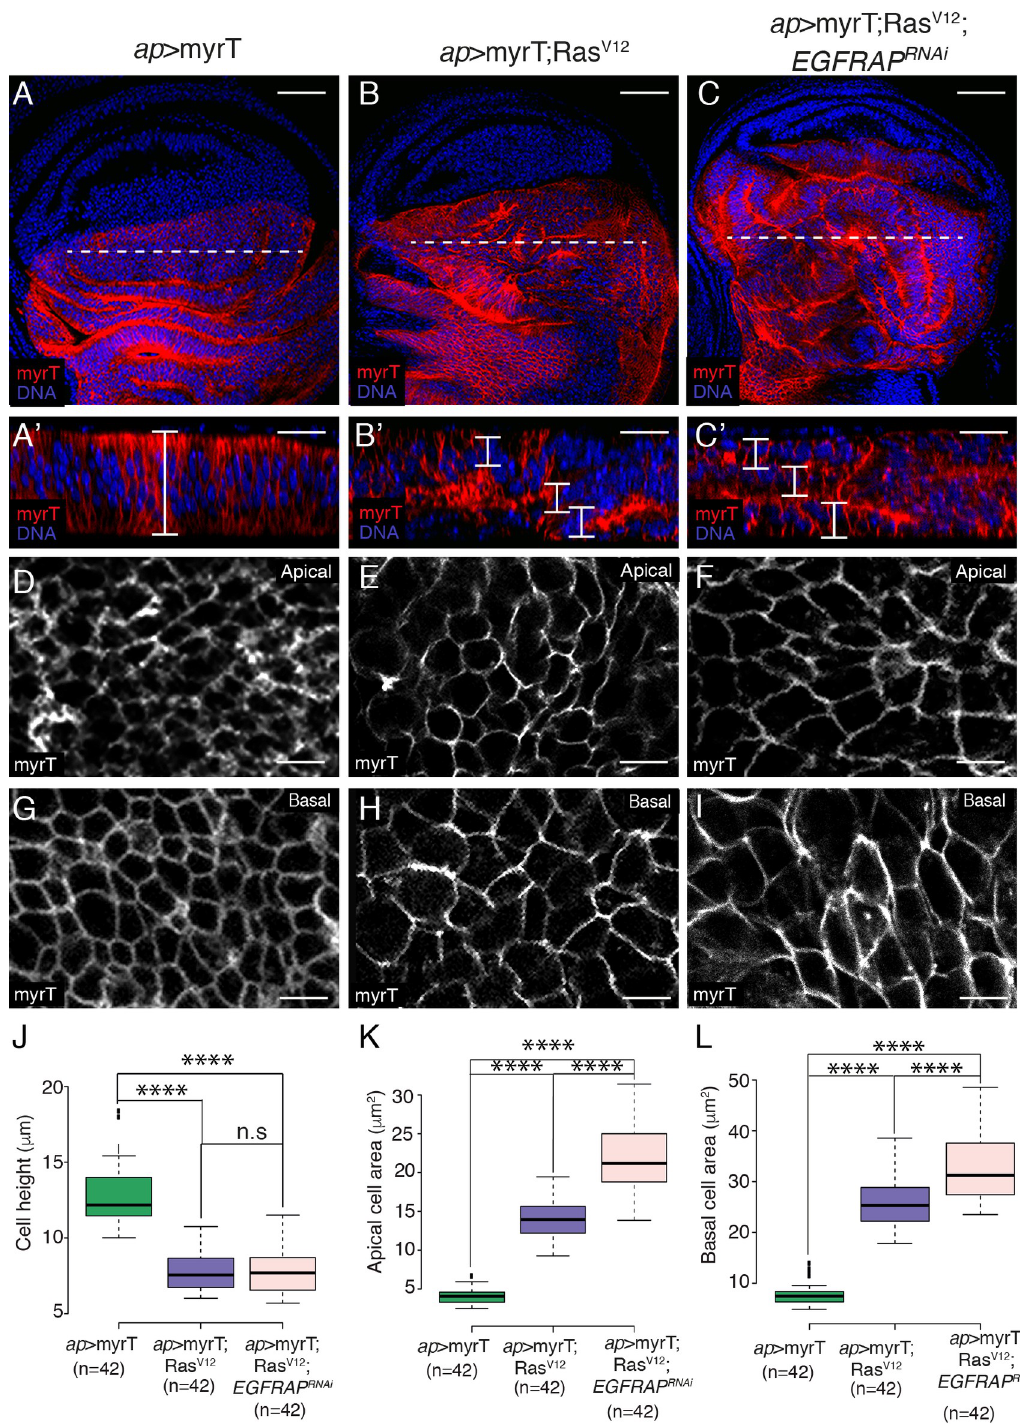
Fig 2. EGFRAP knockdown increases Ras V12 -dependent cell shape changes and growth in Drosophila wing imaginal discs. (A-C) Maximal projection of confocal images of wing imaginal discs from third-instar larvae expressing myristoylated-Tomato (MyrT, red) and the indicated UAS transgenes under the control of ap -Gal4, stained with anti-Tomato (red) and the nuclear marker Hoechst (DNA, blue). (A’-C’) Confocal xz sections along the white dotted lines of wing discs shown in A-C. The apical side of wing discs is at the top. Brackets indicate cell height. (D-F) Apical and (G-I) basal surface views of the indicated genotypes. (J-L) Box plots of the cell height (J), apical cell area (K) and basal cell area (L) of the indicated genotypes. The statistical significance of differences was assessed with a t-test, ���� P value < 0.0001. Scale bars, 50 μ m (A-C), 30 μ m (A’-C’) and 10 μ m